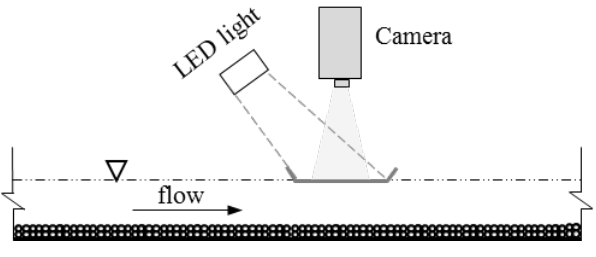
Figure 12. Sketch of the experimental setup.